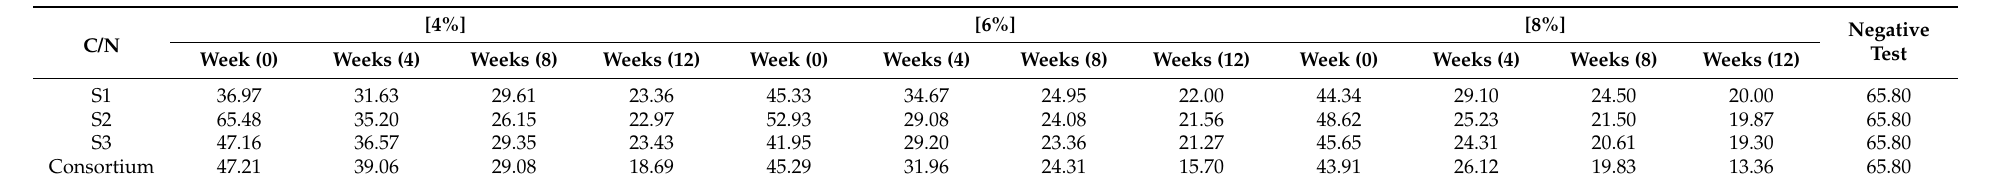
Table 4. Evolution of C/N ratio of the three strains isolated (S1: Strain 1; S2: Strain 2; S3: Strain 3) and their consortium as function of the time at different inoculum doses (4%, 6%, and